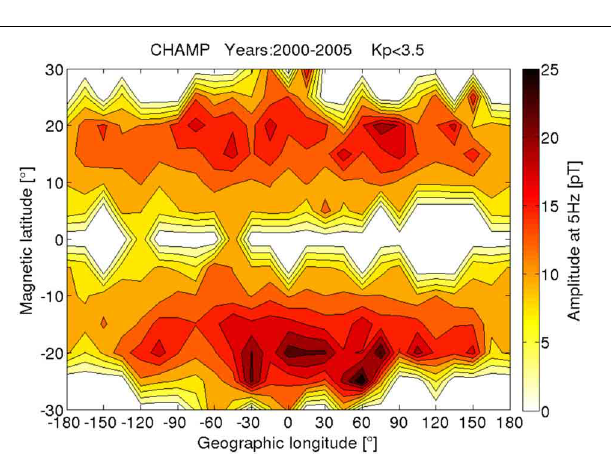
FIGURE 5 | Amplitude distribution of plasma density variations. Largest intermediate-scale density fluctuations are observed at the poleward edges of the plasma